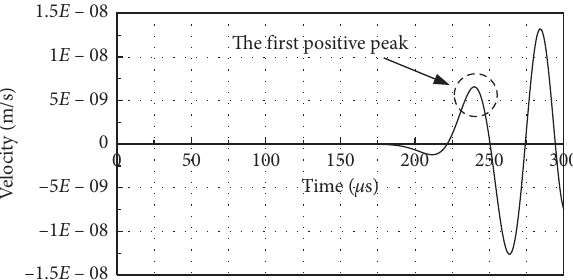
Figure 4: The velocity-time curve of receiving point at a depth of 4m.